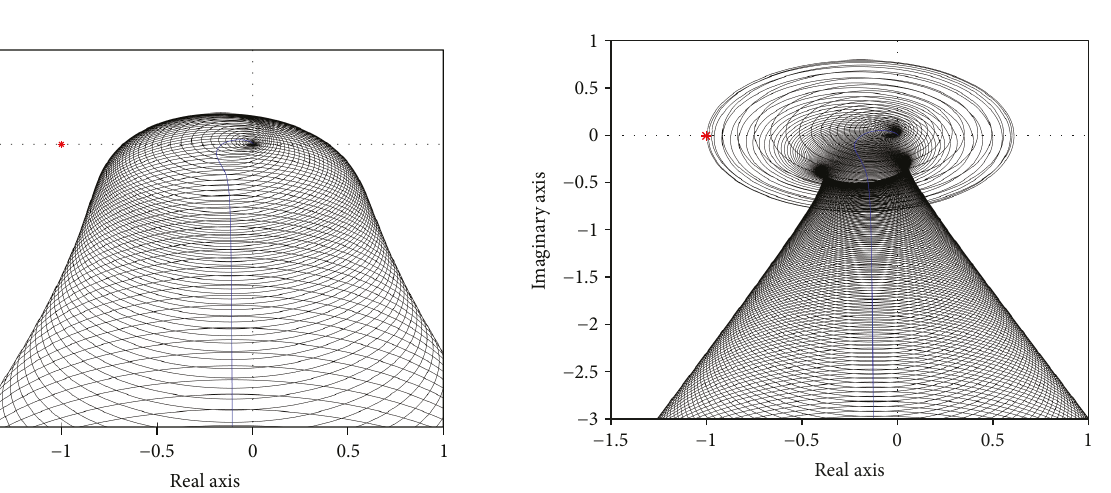
Figure 11: Value sets of FO interval polynomial (23) for P = 2 065 [55].